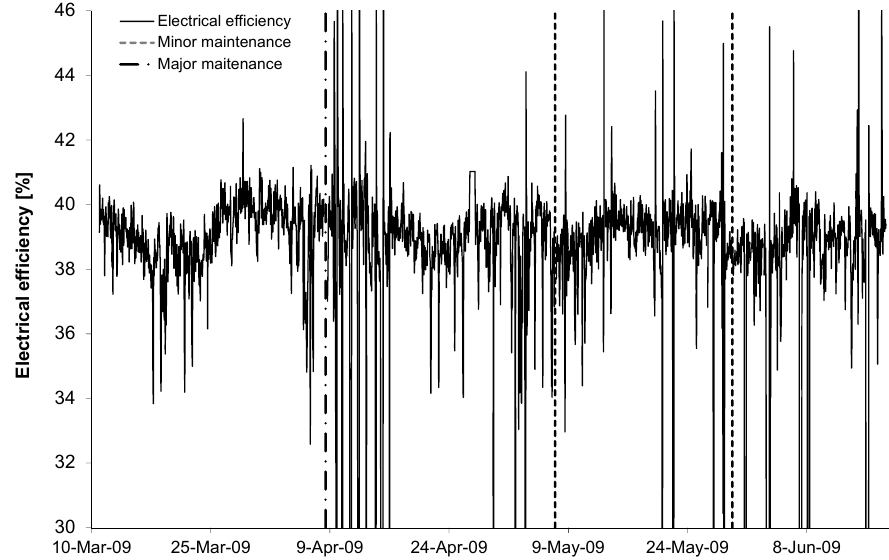
Figure 4. Recorded data for electrical efficiency from 10-Mar-09 to